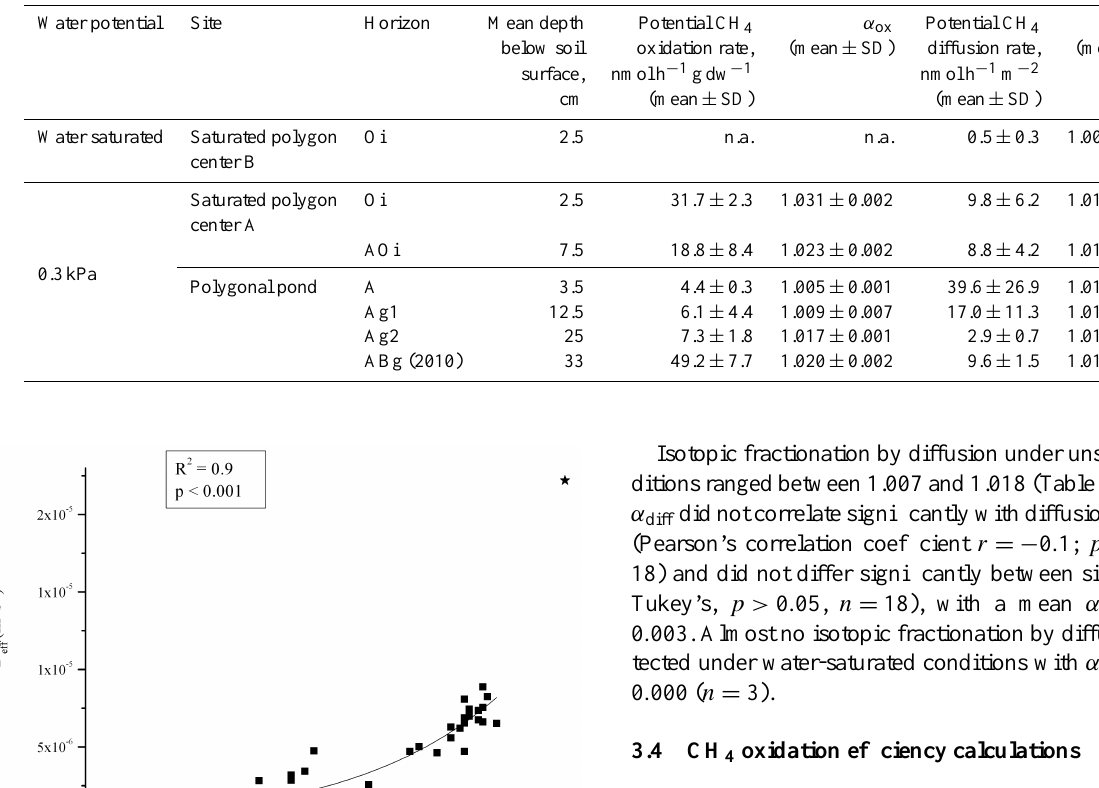
Table 2. Potential methanotrophic activity, potential rates of CH 4 diffusion and isotopic fractionation factors for diffusion and oxidation calculated for the different horizons of the studied sites. Potential diffusion rates of the saturated polygon center A and the polygonal pond were determined at field capacity (0.3kPa) and of the saturated polygon center B at water saturation; n.a. = not analyzed.